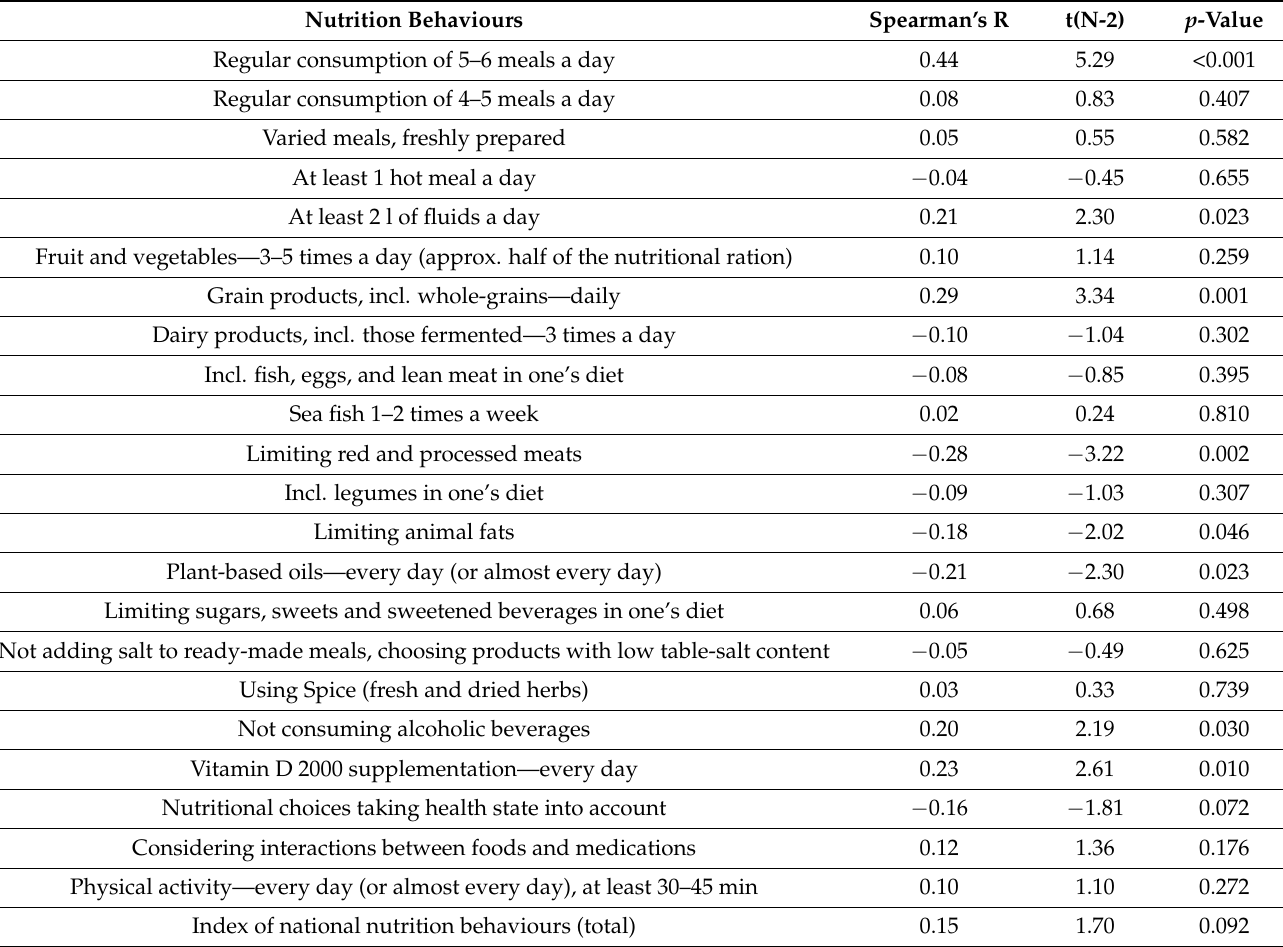
Table 3. Correlations between satisfaction with life (SWLS) and nutrition behaviours among women participating in the “Healthy Active Senior” programme (Spearman’s correlation